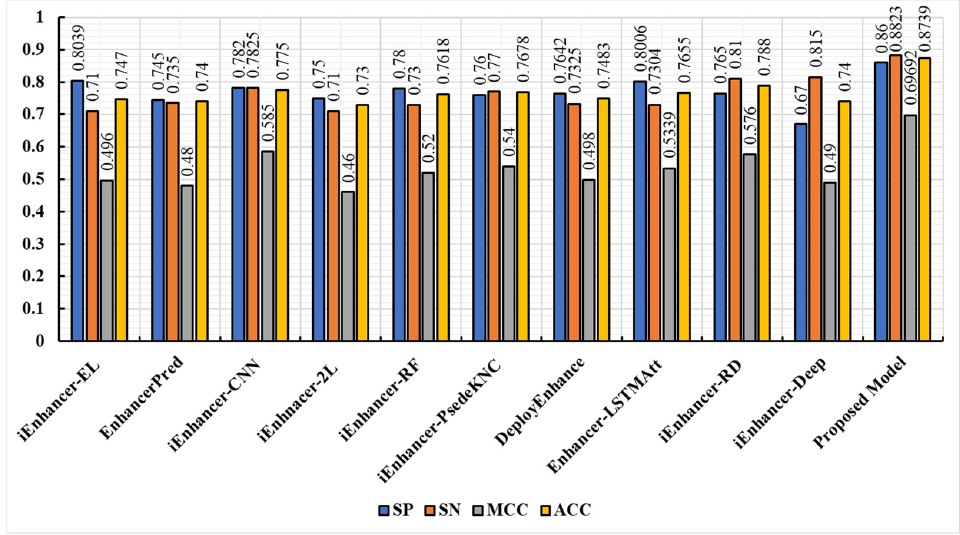
Figure 5. Performance comparison of the proposed model with baseline techniques (Stage 1) .